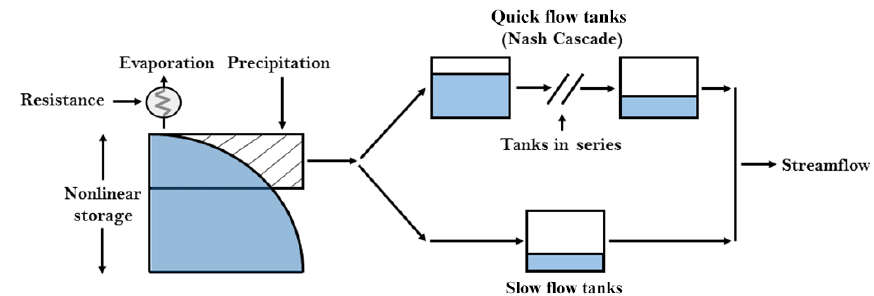
Figure 4. Schematic diagram of